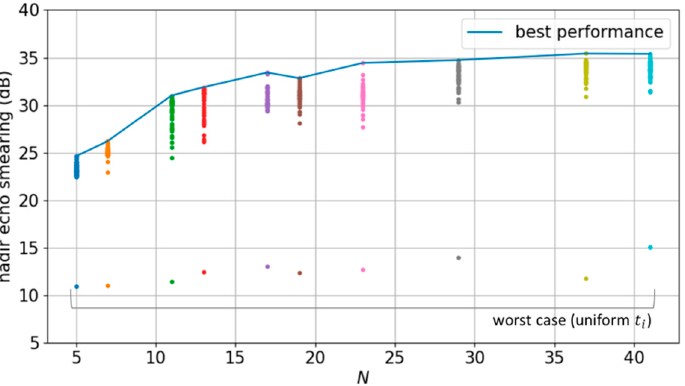
Figure 9. Simulation results of nadir echo smearing for each N with different sets of t i values. Table 2. Performance of Nadir Echo Suppression (Optimum Set of t i ) vs. Number of Distinct Waveforms.